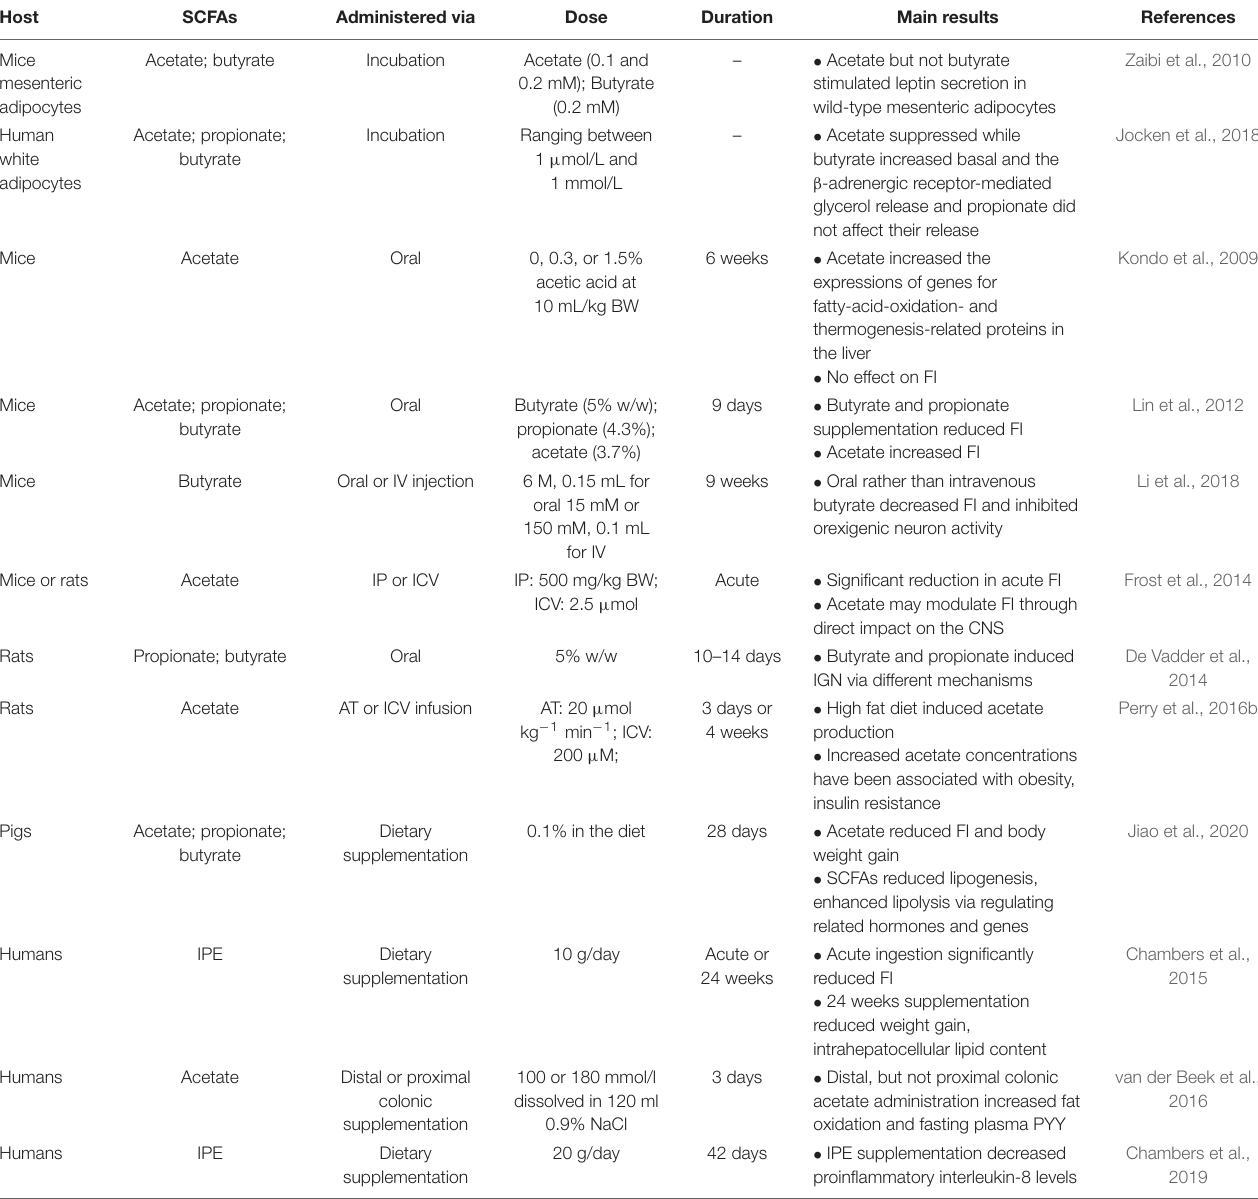
TABLE 1 | Summary of studies in short chain fatty acids (SCFAs) differentially affect host energy